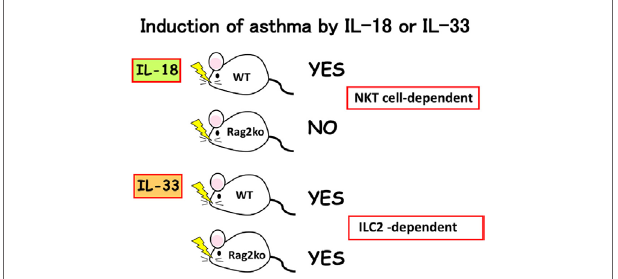
FigURe 4 | Induction of bronchial asthma by intranasal administration of interleukin (IL)-18 or IL-33. As natural killer (NK)T cells constitutively express IL-18R, intranasal administration of IL-18 into wild-type mice, but not into Rag2Ko mice induced bronchial asthma by induction of IL-4 and IL-13 from NKT cells. In contrast, intranasal administration of IL-33 into wild-type mice and Rag2Ko mice equally induce bronchial asthma, because Rag2Ko mice are equipped with ILC2 which express IL-33R and produce IL-13 in response to